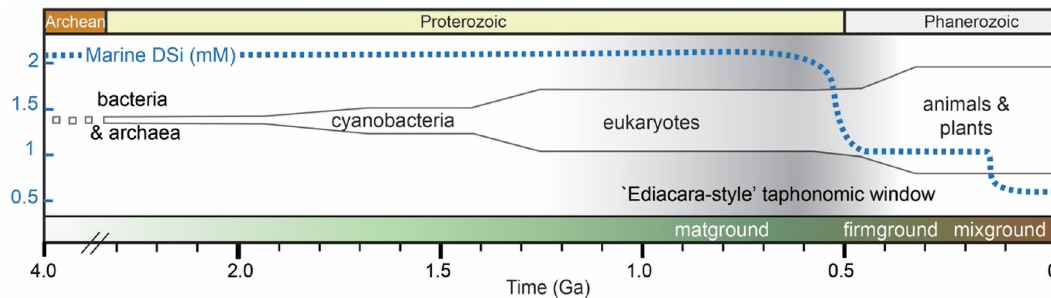
Figure 1. Temporal variation in marine dissolved silica (DSi) levels, in the context of other major environmental and biotic changes over this interval. Representation of inferred temporal changes in DSi follows Ref. 25 . Changes in the relative abundance of seafloor substrate type (matgrounds, firmgrounds, and mixgrounds) 27 are indicated in the lower bar. The spindle plot represents the evolutionary diversification of major clades (modified after Ref. 73 ). The shaded grey vertical line shows the estimated duration of the Ediacara- style taphonomic window 6